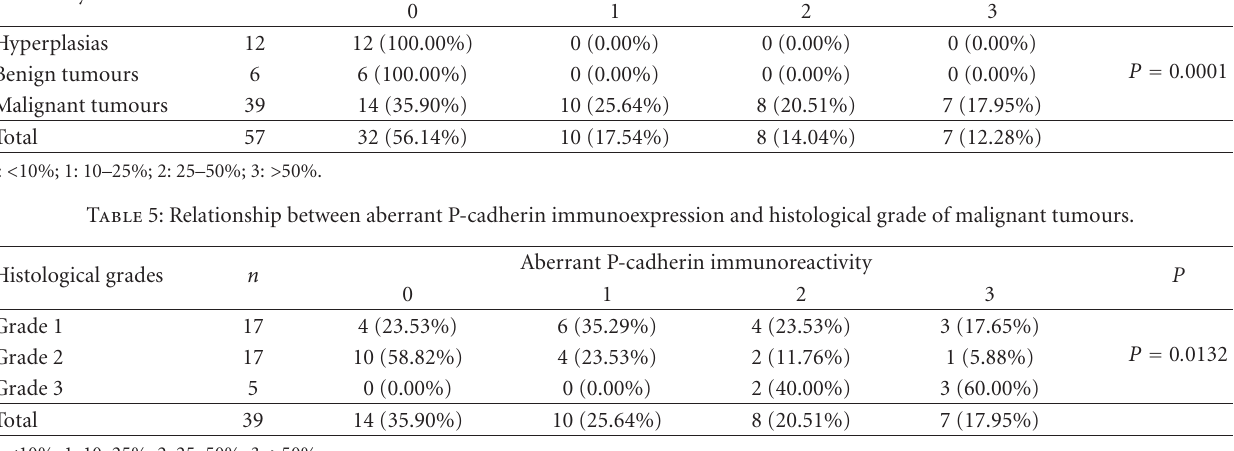
Table 4: Relationship between aberrant P-cadherin immunoexpression and mammary lesions. Mammary lesions